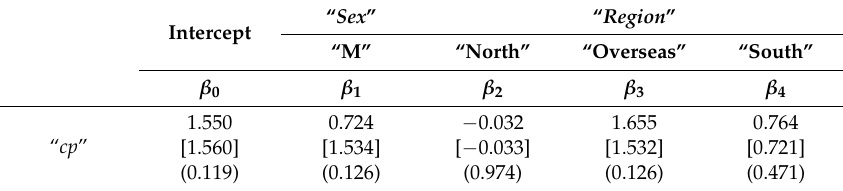
Table 5. Estimation results of “ cp ” against “ Region ” and “ Sex